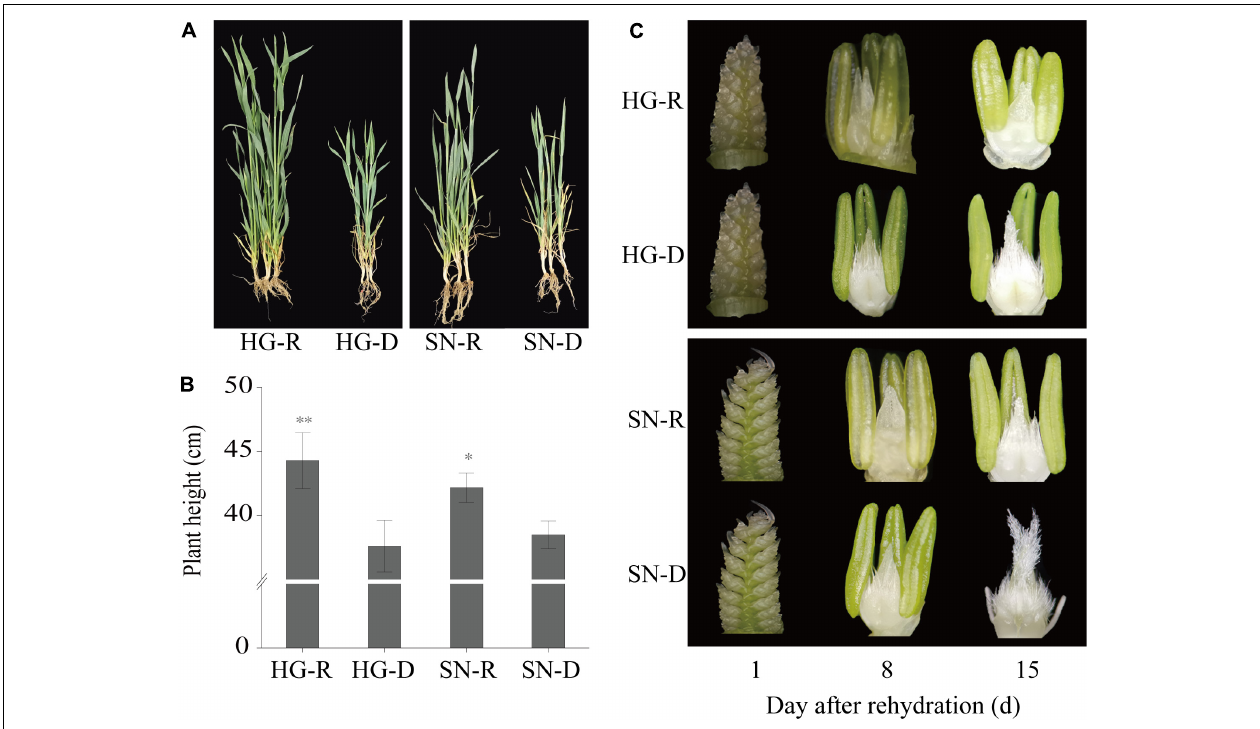
FIGURE 2 | The drought-tolerant wheat variety “Hengguan35” (HG) showed better rehydration-compensation phenotypes than the drought-sensitive wheat variety “Shinong086” (SN). (A) Plant morphology of HG and SN at 15 dpr. “*, **” indicate significant difference at 0.05 level. ** P < 0.01; * P < 0.05. (B) Plant height was measured at 15 dpr. (C) Spikes were isolated and observed using a microscope at 1, 8, and 15 dpr. R, rehydrated plants; D, plants under continuous drought stress.